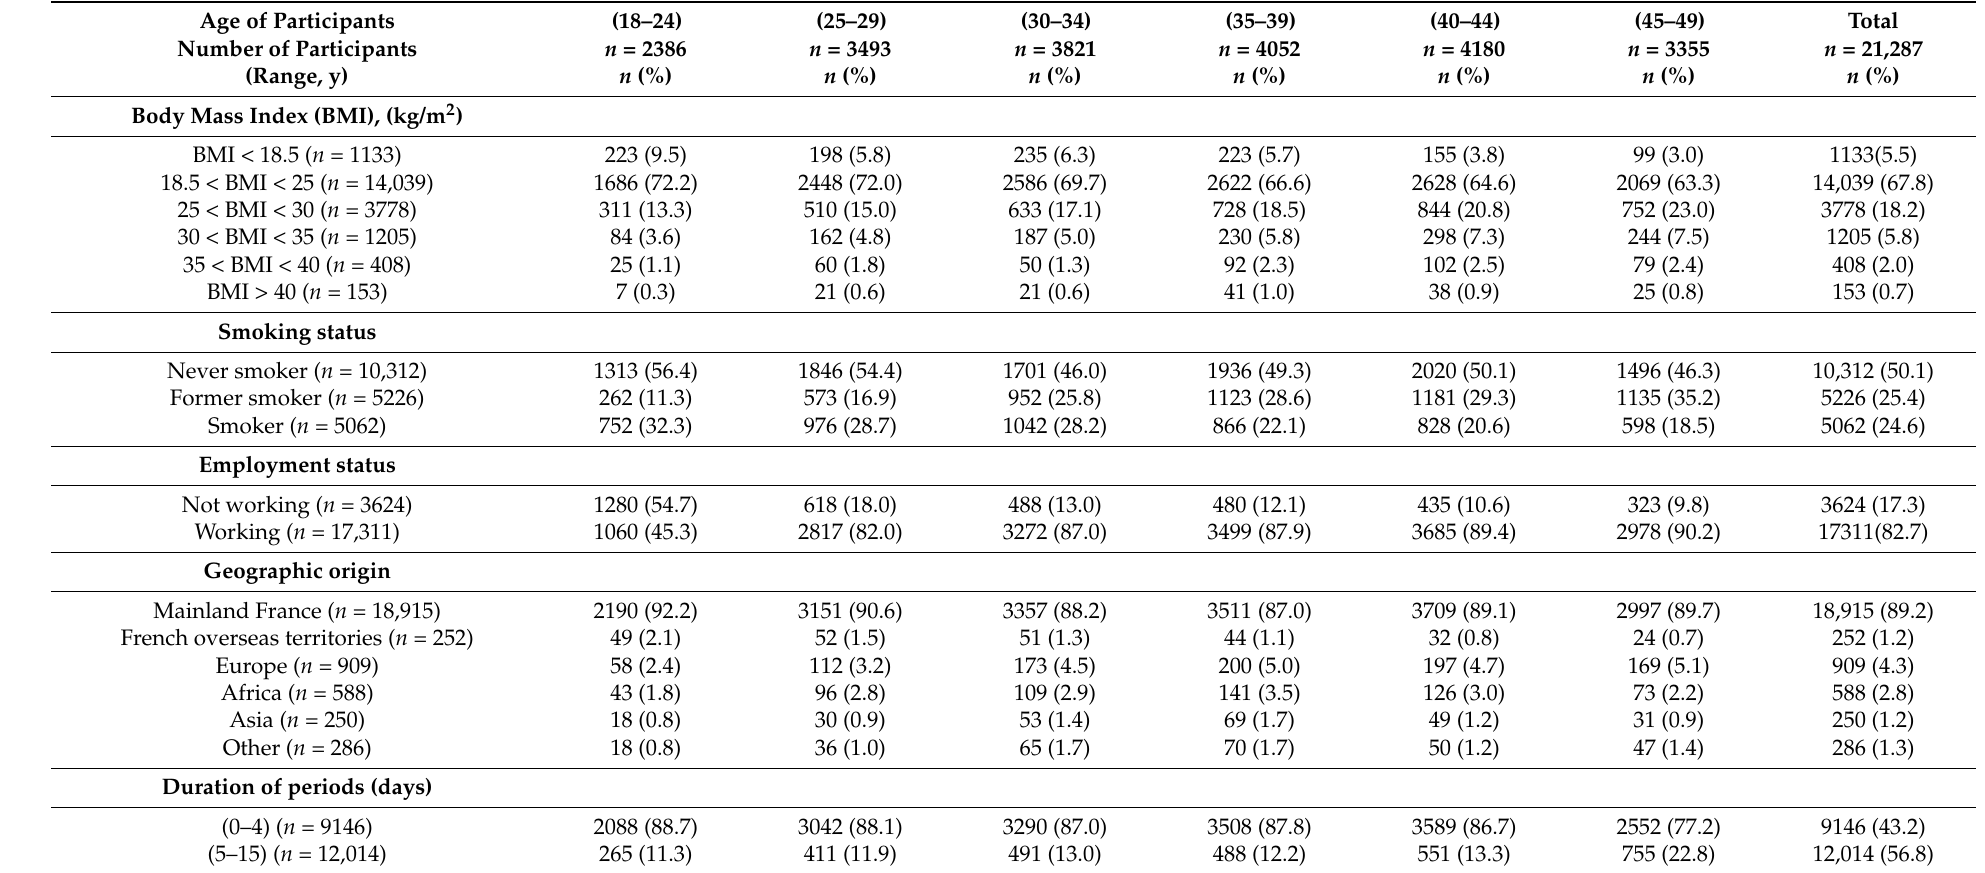
Table 1. Comparison of baseline characteristics among participants, n =